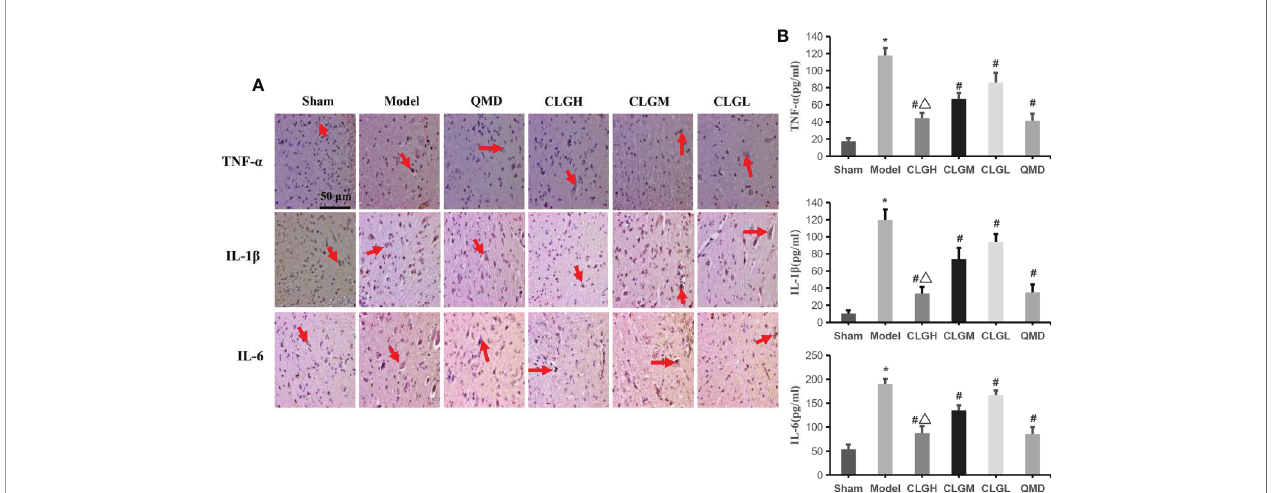
FIGURE 5 | Inhibitory effects of CLG on the in fl ammatory factors in the rat models of bone cancer pain. (A) Immunohistochemical results of TNF- a , IL-1 b , and IL-6 proteins in rat spinal cord (n = 3). The arrows indicate the positive expression. (B) Elisa results of TNF- a , IL-1 b , and IL-6 proteins in rat serum (n = 6). * P < 0.05 vs. sham, # P < 0.05 vs. Model, D P < 0.05 vs. CLGL and